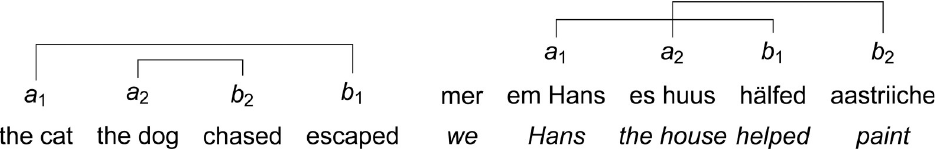
Fig 1. Nested dependencies (left) versus crossed dependencies (right ). In the English example to the left, “ the cat the dog chased escaped ,” the dependencies do not cross. In the Swiss-German example (from [24]), to the right, “ mer Hans es huus hälfed aastriiche ” (we helped Hans paint the house), the dependencies cross.